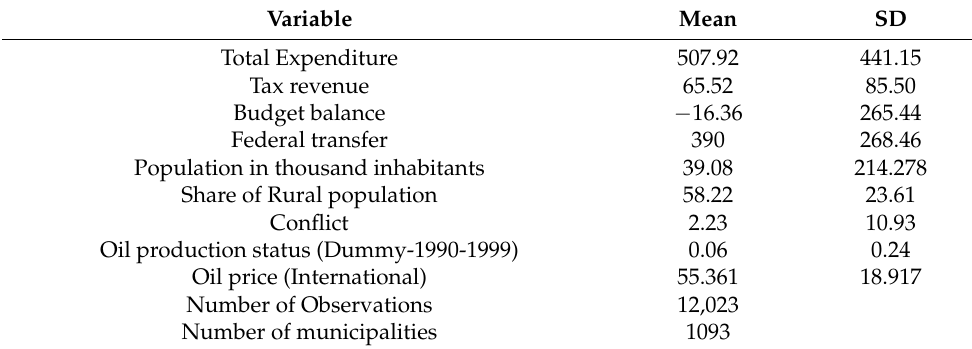
Table 2. Descriptive